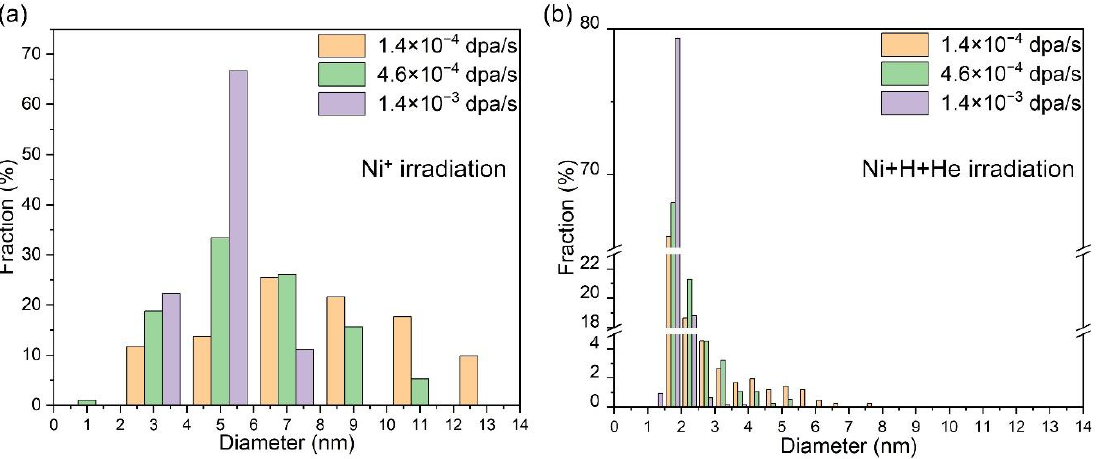
Figure 4. The size distribution of cavities after Ni single ion ( a ) and (Ni+H+He) triple ion irradiation ( b ). The orange, green, and purple correspond to the dose rates of 1.4 × 10 − 4 dpa/s, 4.6 × 10 − 4 , and 1.4 × 10 − 3 dpa/s, respectively. In panel ( b ), two breakpoints at 5–18 and 23–65 are set in the y -axis for